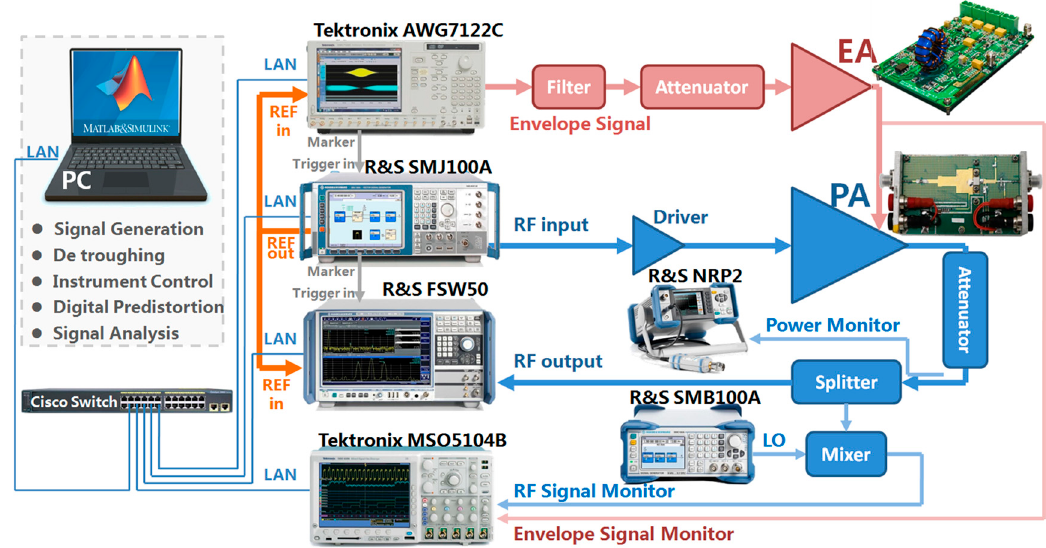
Figure 9. Measurement setup of the envelope tracking (ET) experimental system diagram.